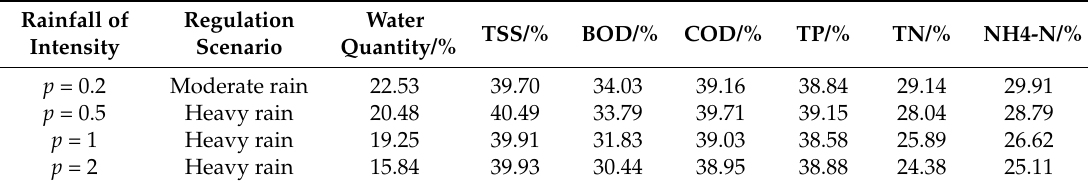
Table 5. Reduction in indexes after construction of DongHaoChong deep tunnel for rainstorms with different design recurrence